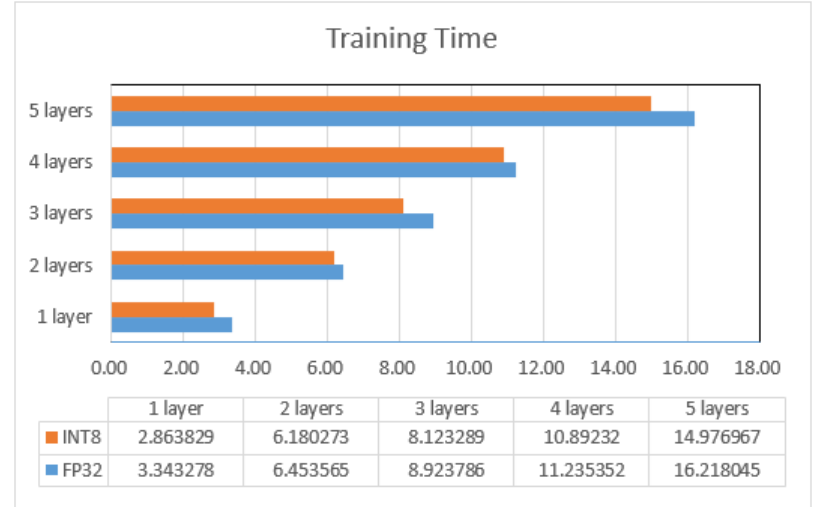
Figure 6. Training time of models before quantization.